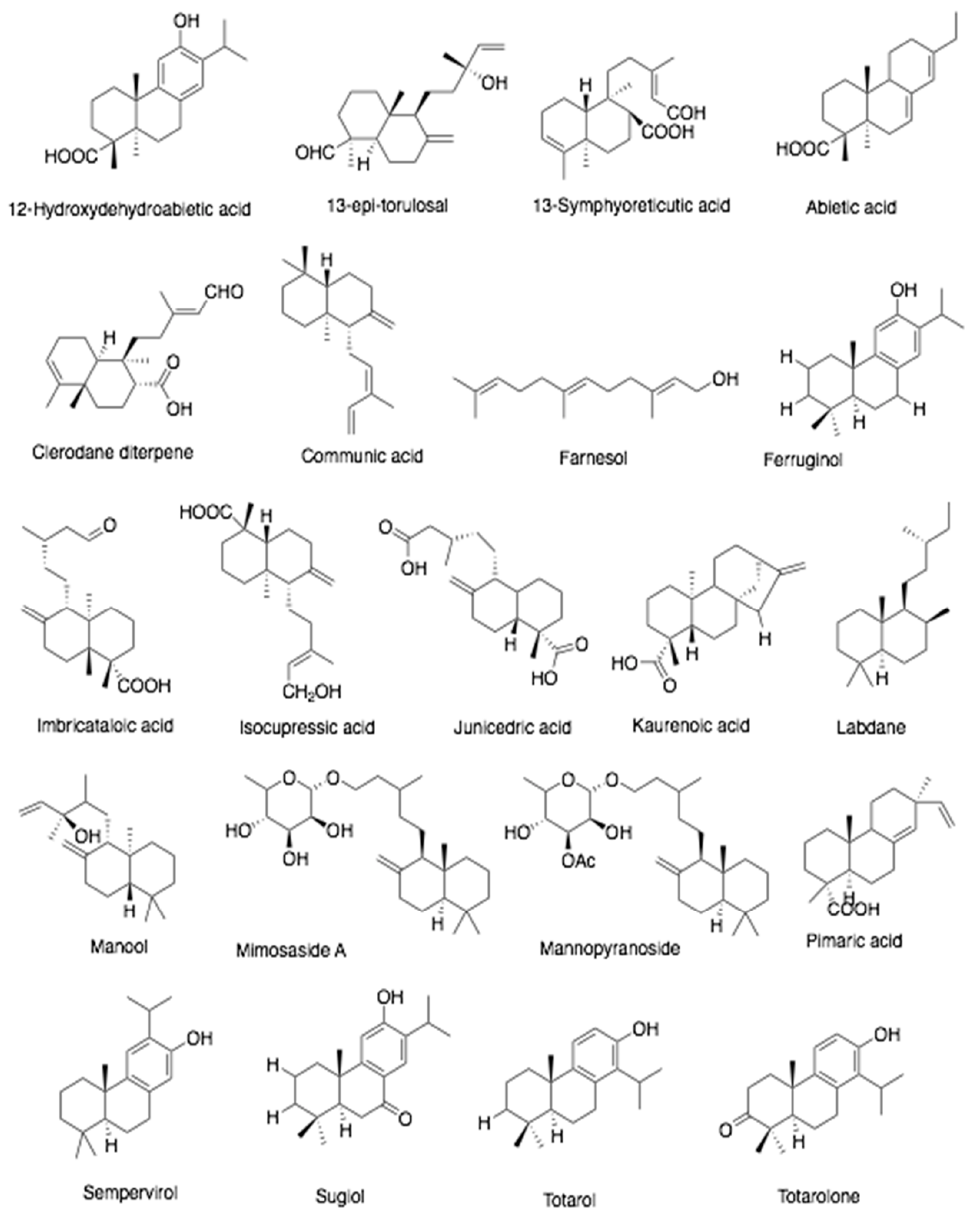
Figure 6. Chemical structures of terpenoids found in propolis.